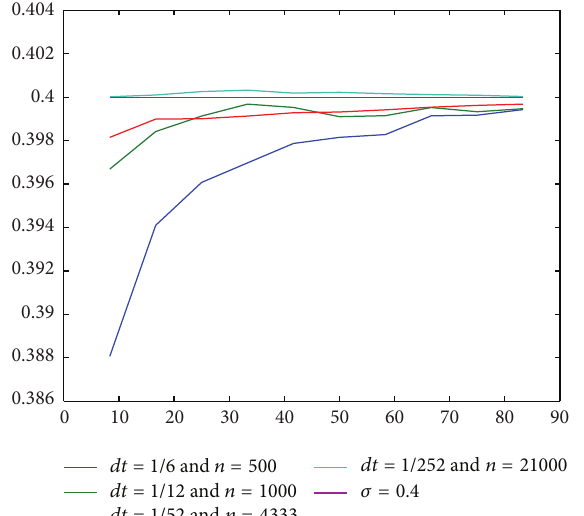
Figure 3: 𝜎 estimation results. 𝑑𝑡 = 1/6, 1/12, 1/52, and 1/252, 𝑛 = 500, 1000, 4333, and 21000,